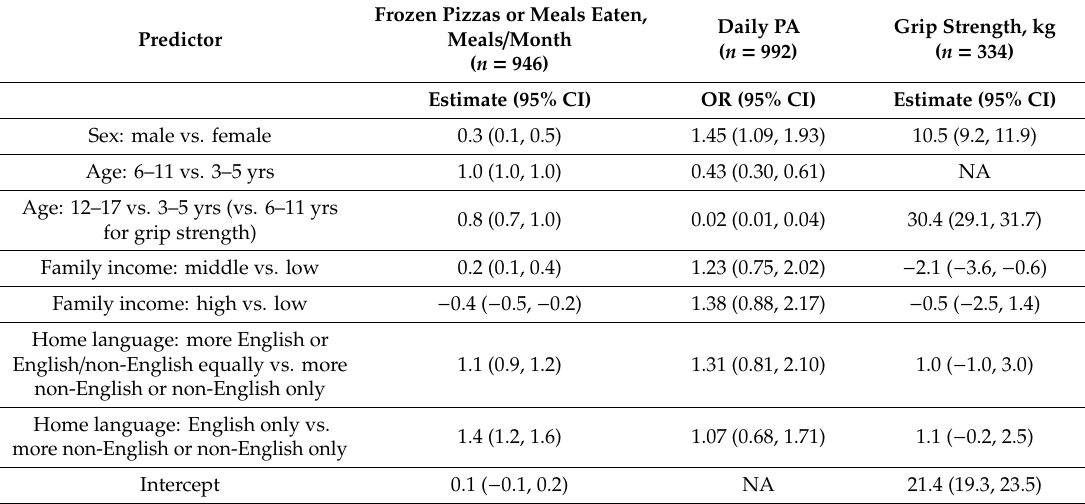
Table 6. Associations of acculturation with convenience food consumption, daily physical activity, and muscle strength in Asian American